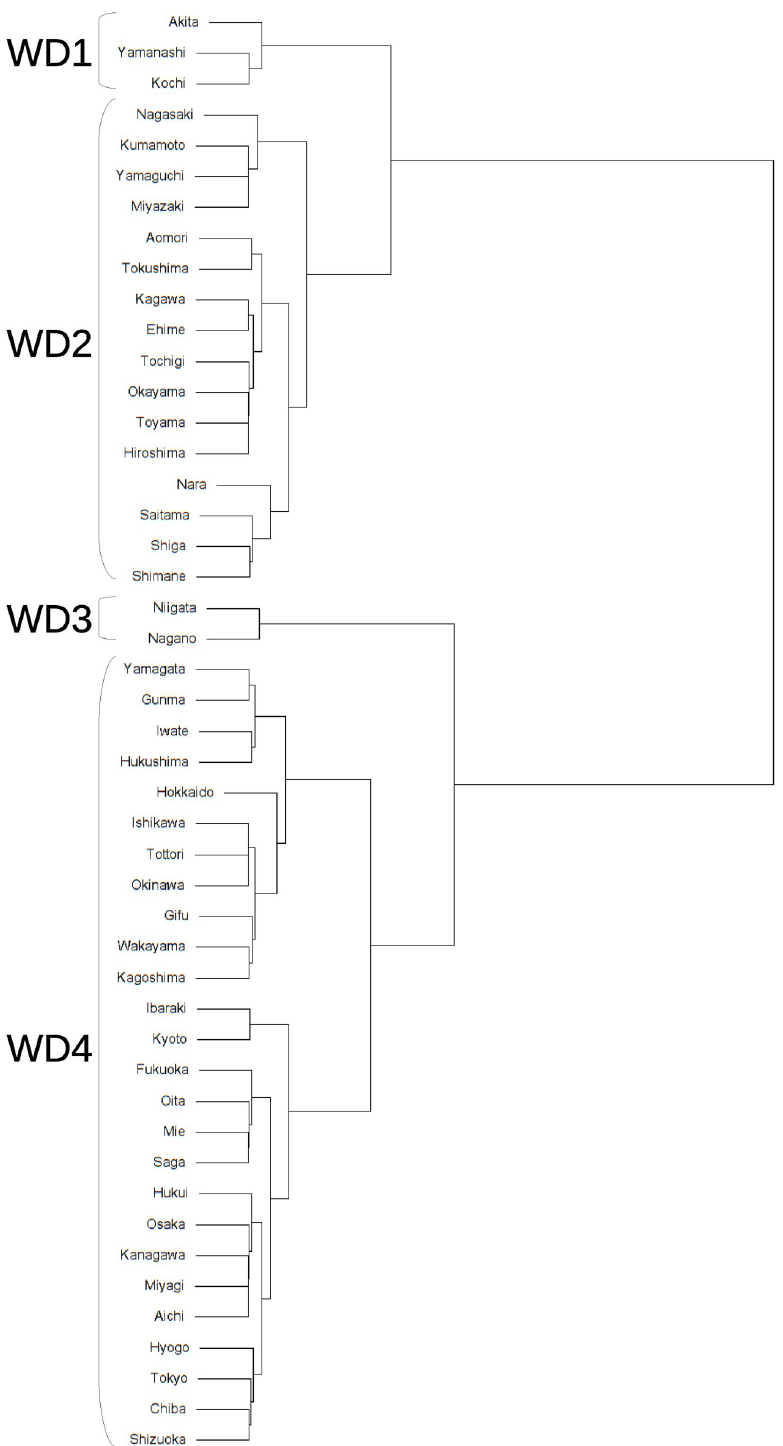
Fig 15. A dendrogram for seasonal indices in domestic guests for tourism.